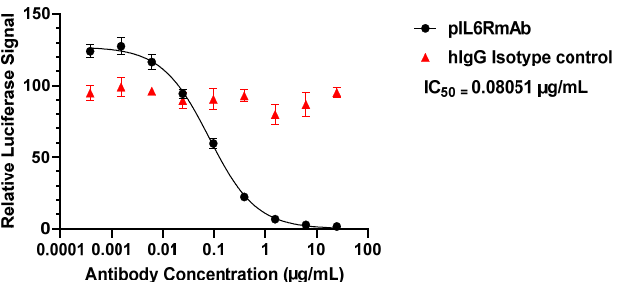
Figure 3. Specific binding of pIL6RmAb to IL-6R. pIL6RmAb was serially diluted and incubated with IL-6R coated on microtiter plate. After incubation, pIL6RmAb bound to IL-6R was detected with an HRP-conjugated anti-human-gamma HC antibody. Dilutions of a generic human IgG (hIgG) were used as the IgG isotype negative control. The OD 450 values (mean ± SD) from two inde- pendent experiments are presented.